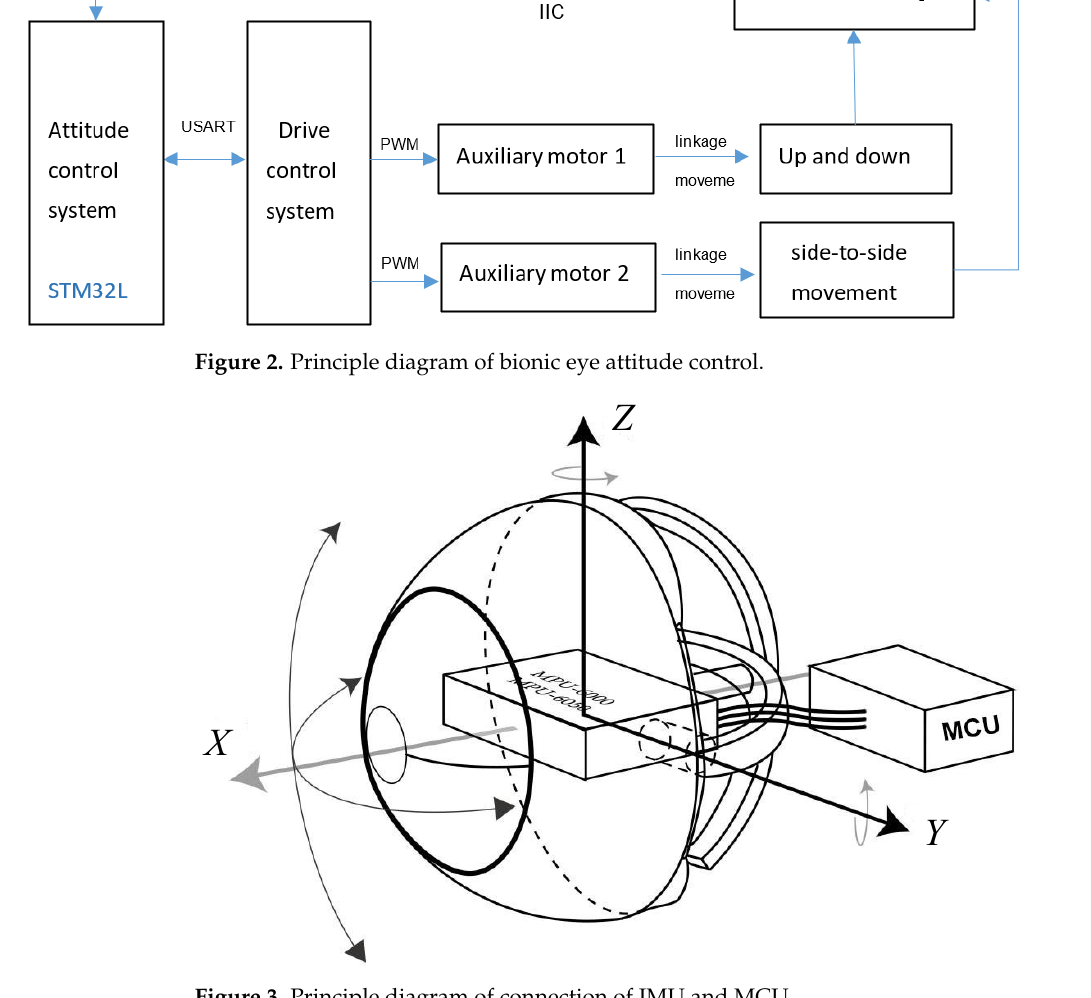
Figure 2. Principle diagram of bionic eye attitude control.